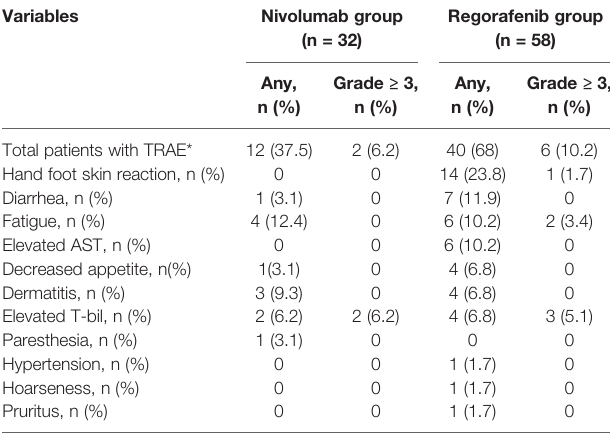
TABLE 4 | Treatment related adverse events (TRAE) in the study population by treatment. Variables